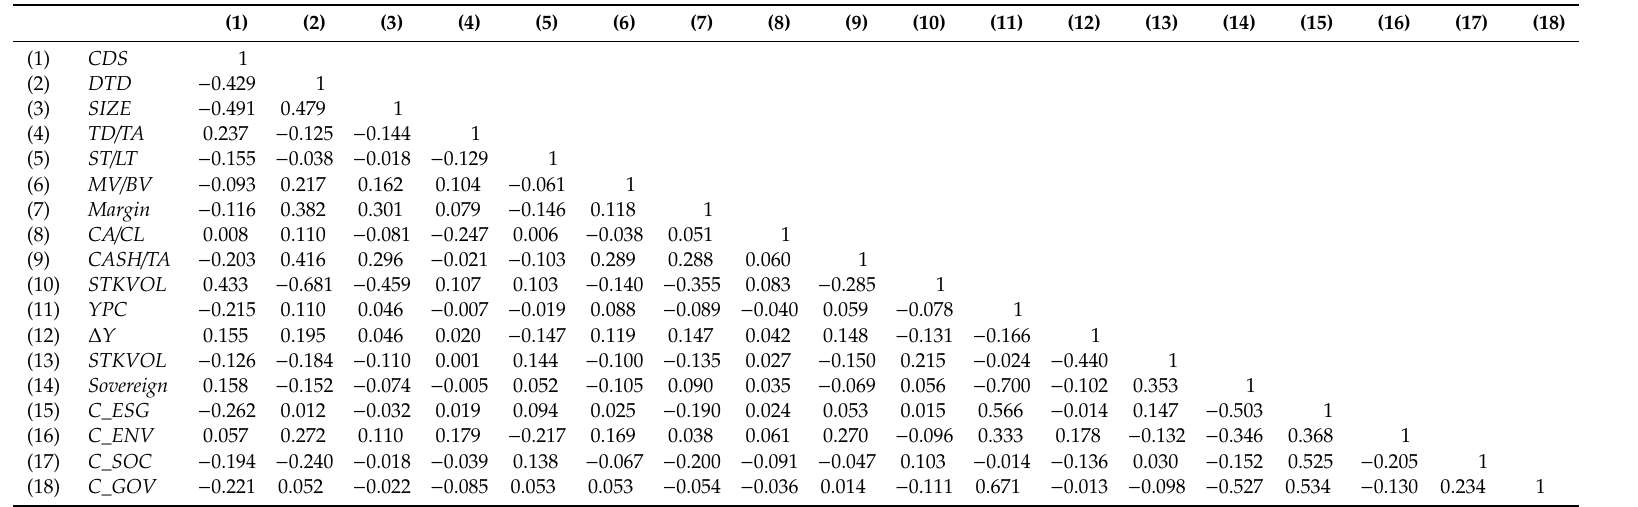
Table 3. Correlation coe ffi